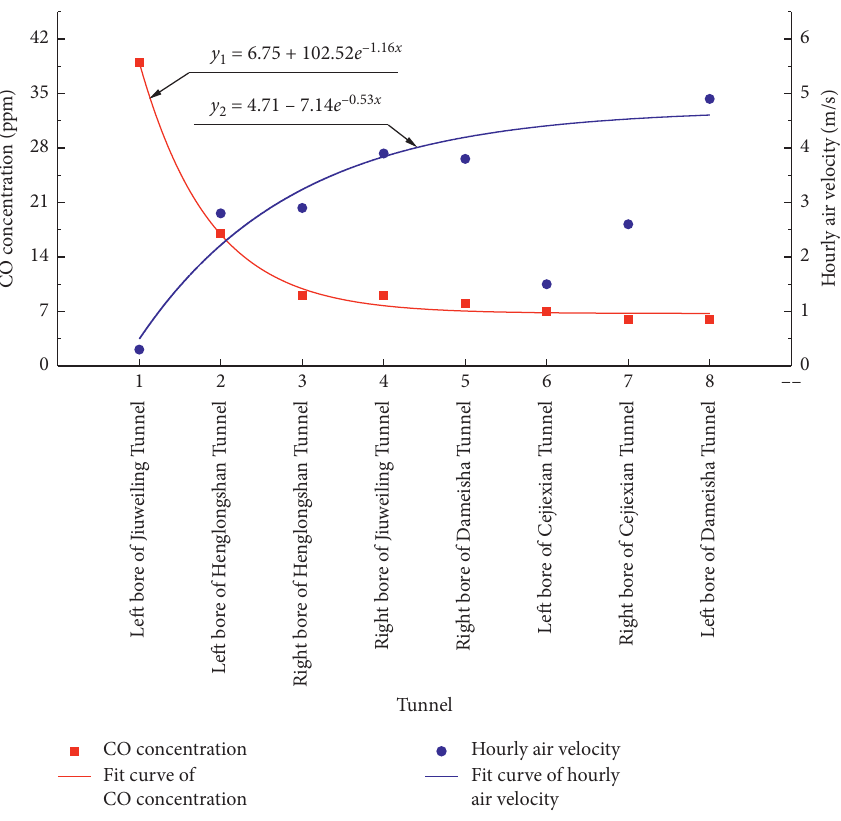
Figure 12: Relationship between maximum CO concentration and hourly air velocity. Table 6: Average vehicle CO emission factors (unit: g/(km ·